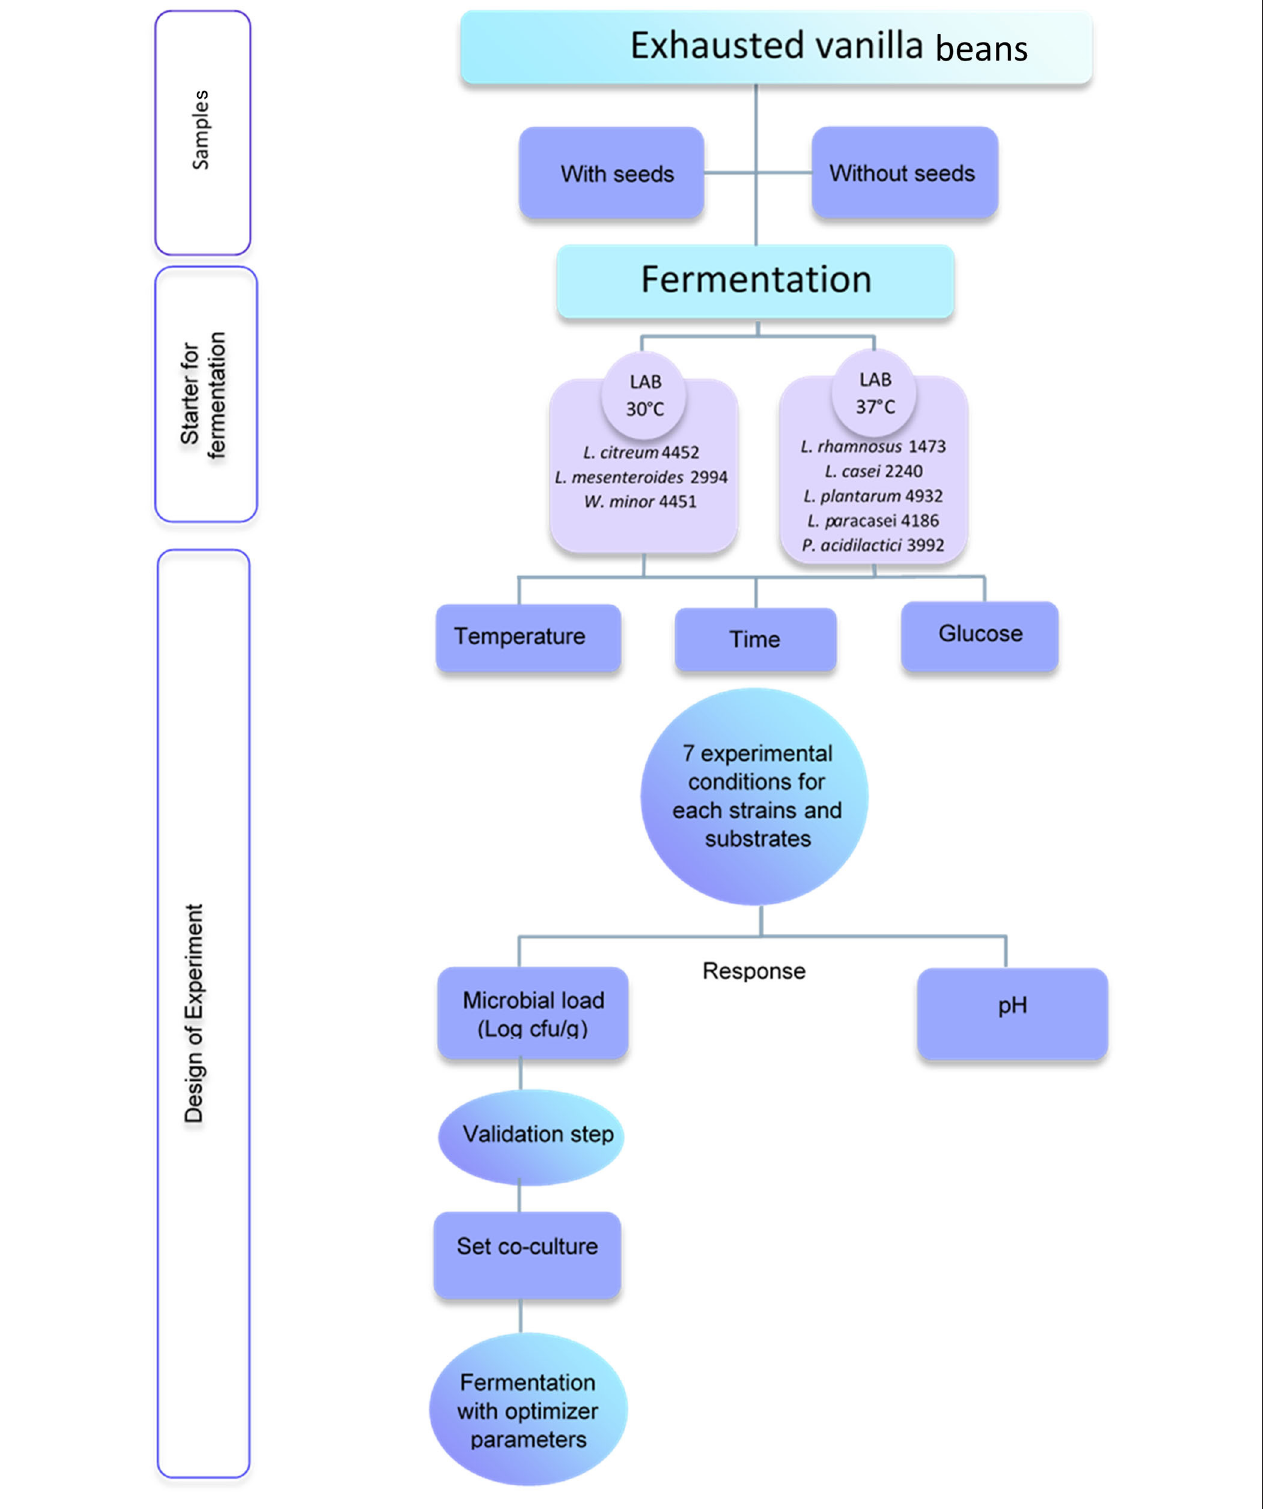
FIGURE 1 | Experimental procedure for fermentation of exhausted vanilla beans.